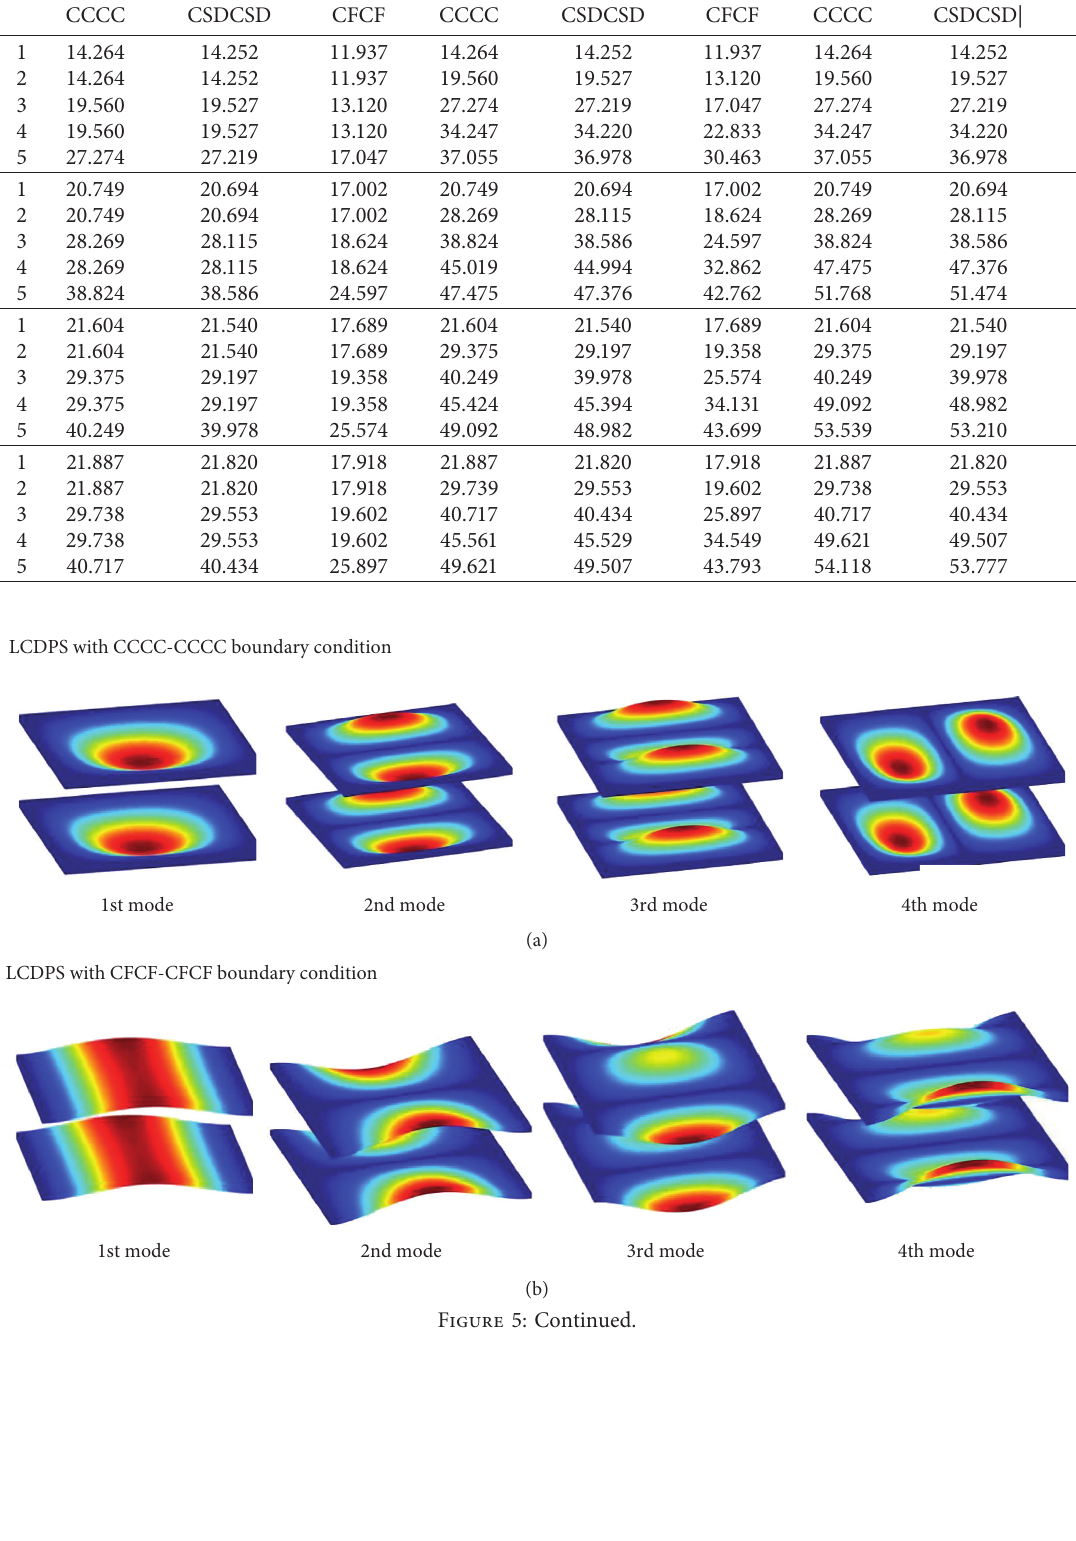
Table 5: Frequency parameters Ω for an LCDPS with different middle spring parameters, layer scheme, and classical conditions. Layer